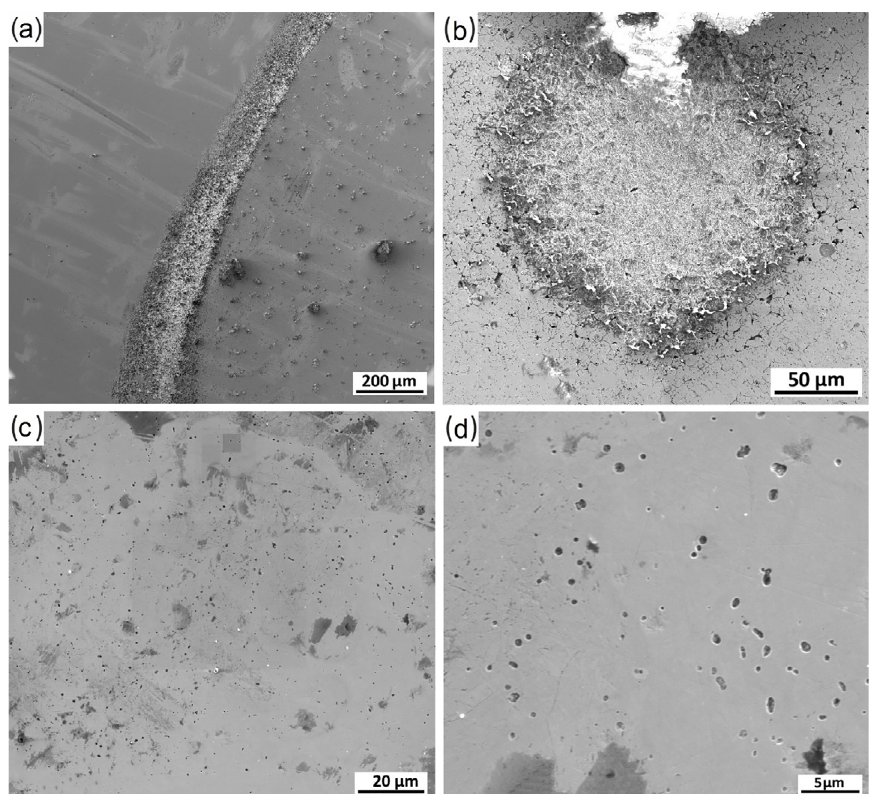
Figure 7. SEM images of corroded zones for different samples (a) and (b) untreated, (c) and (d) N3